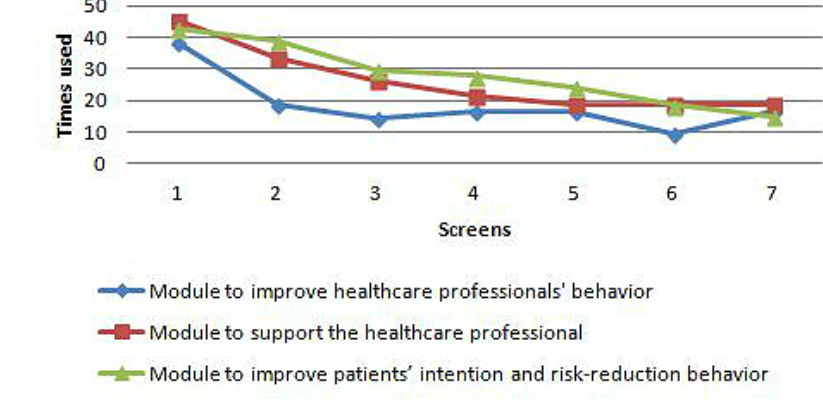
Figure 5. Use of the intervention website